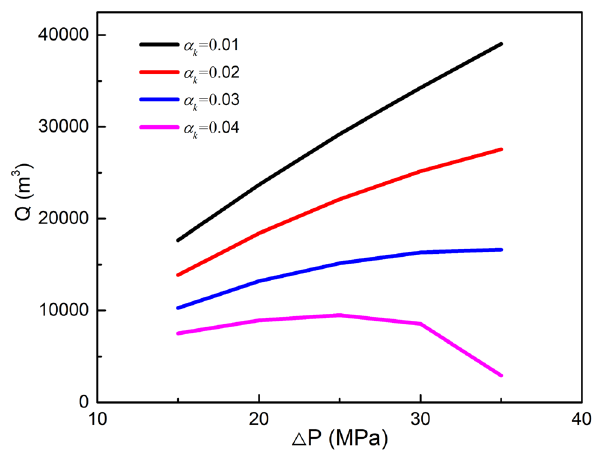
Fig. 8 Cumulative oil production versus pressure drop for different stress-sensitive